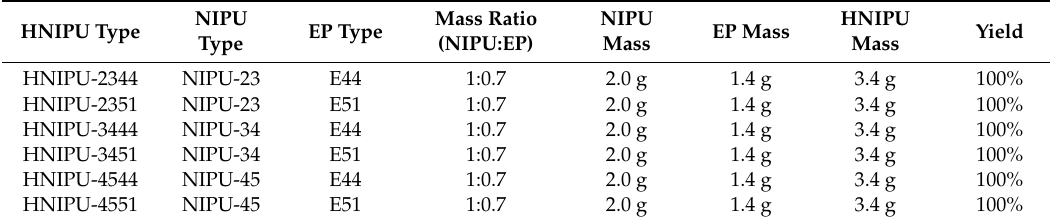
Table 3. The raw materials mass and results of